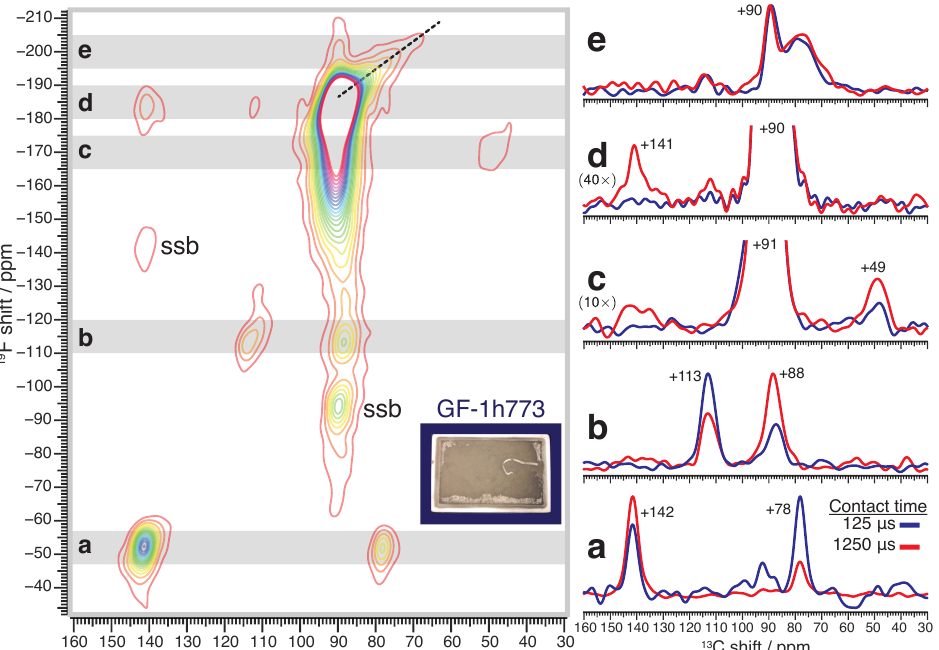
Figure 3. Solid-state 2D { 19 F} 13 C CP HETCOR CPMG MAS NMR spectrum of GF-1h773, acquired using a CP contact time of 1250 µ s. Contours drawn from 5.5 σ noise level up to 12.5% of the 2D signal maximum. Signal integrals over the shaded bands ‘a’ through ‘e’ shown on the 2D spectrum lead to the 1D 13 C correlation profiles shown on the right, which include correlation profiles from a second CP HETCOR experiment at a shorter contact time of 125 µ s, scaled to the same maximum intensity as the long contact time profile. “ ( N × )” indicates additional zoom to baseline by factor N . “ssb” = spinning